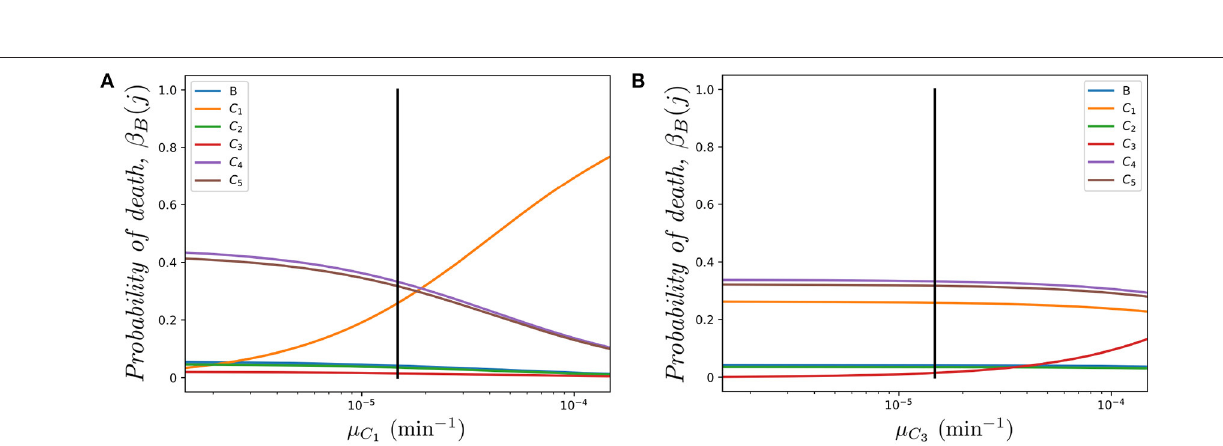
FIGURE 6 | Effect of varying µ C µ C . The vertical black line represents the value µ 3